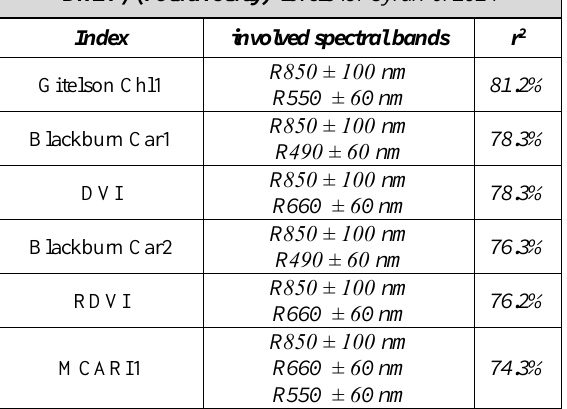
Table 4. The highest correlation rates regarding the estimation of Brix-to-TA levels for Syrah in